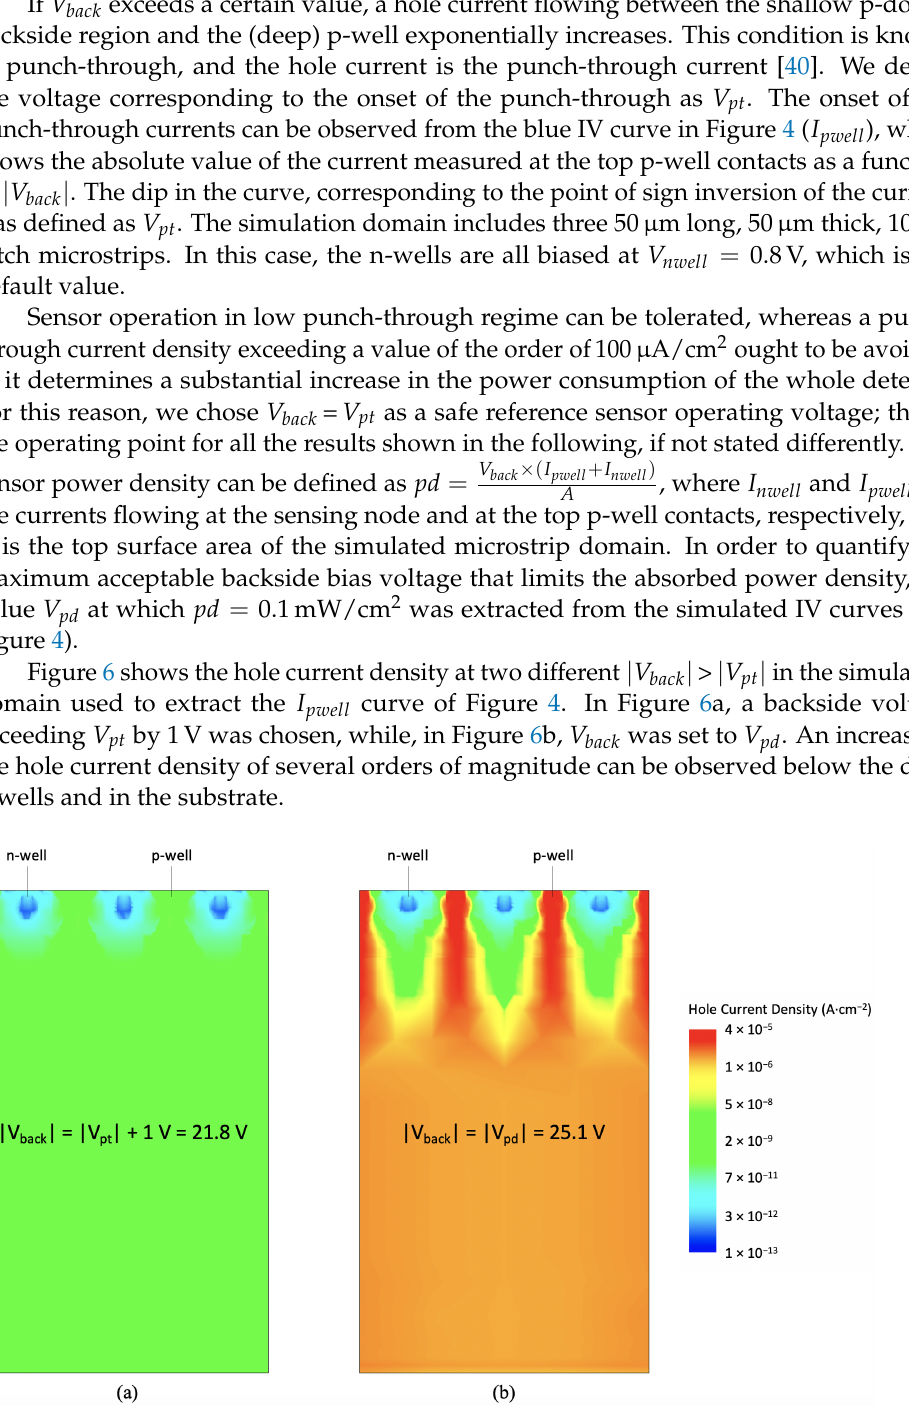
Figure 6. Hole current density in a simulated sensor domain including three microstrips in punch- through condition at two different V back